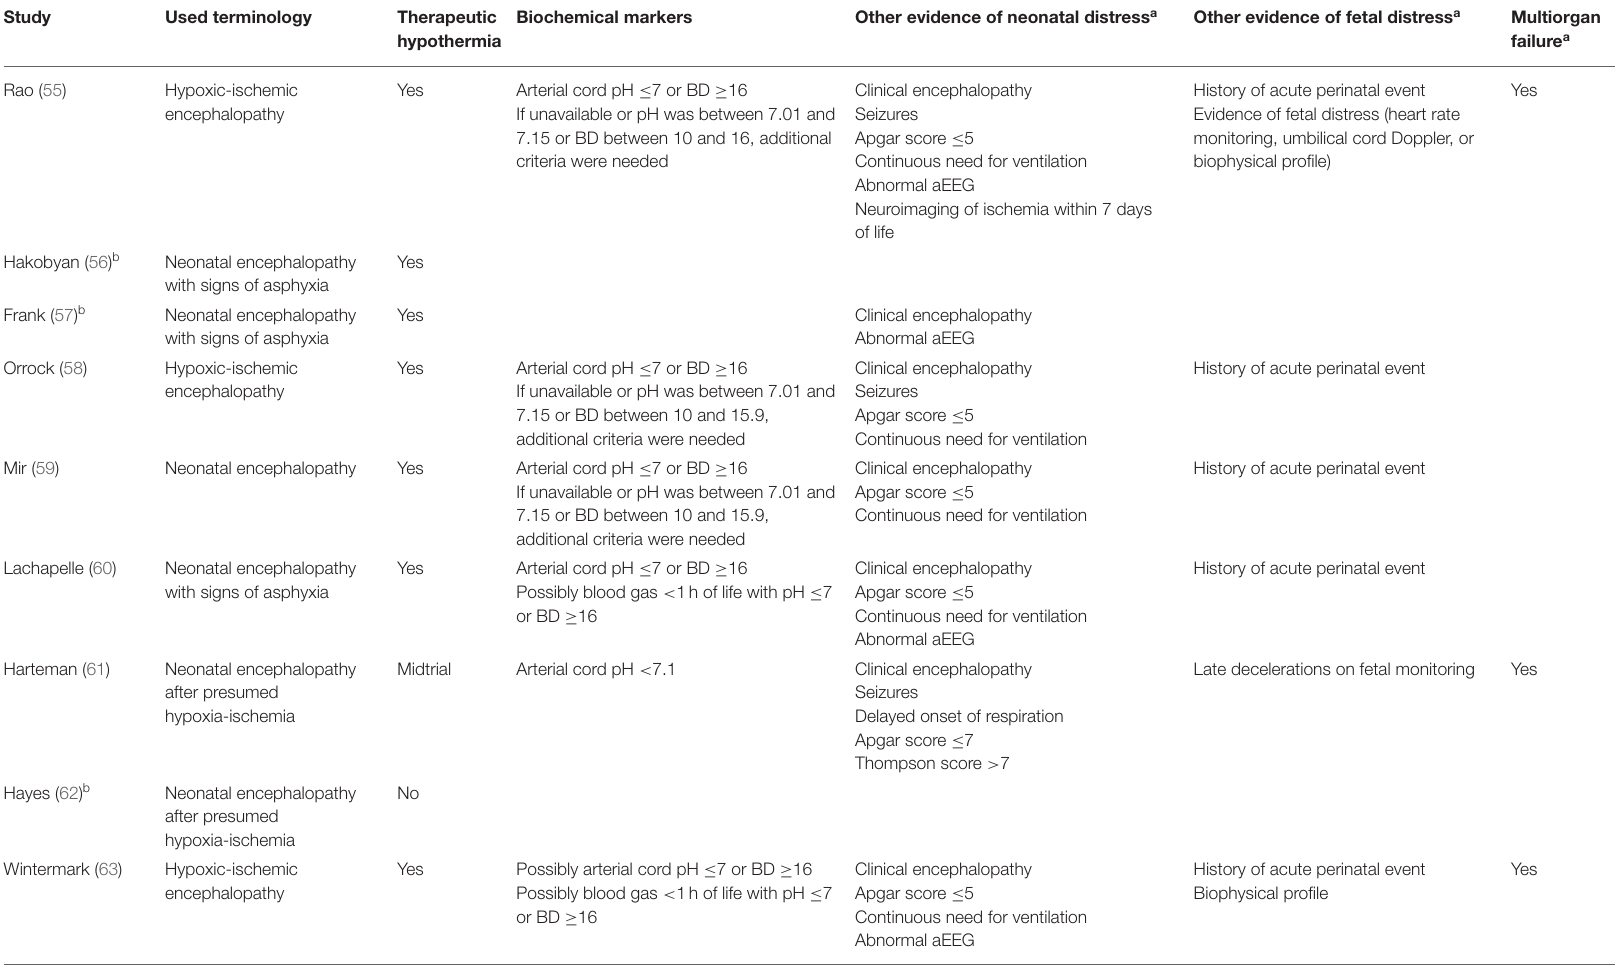
TABLE 2 | Possible markers of hypoxia-ischemia as part of inclusion criteria in the studies investigating the association between newborn encephalopathy, perinatal infection, and neurological outcome.